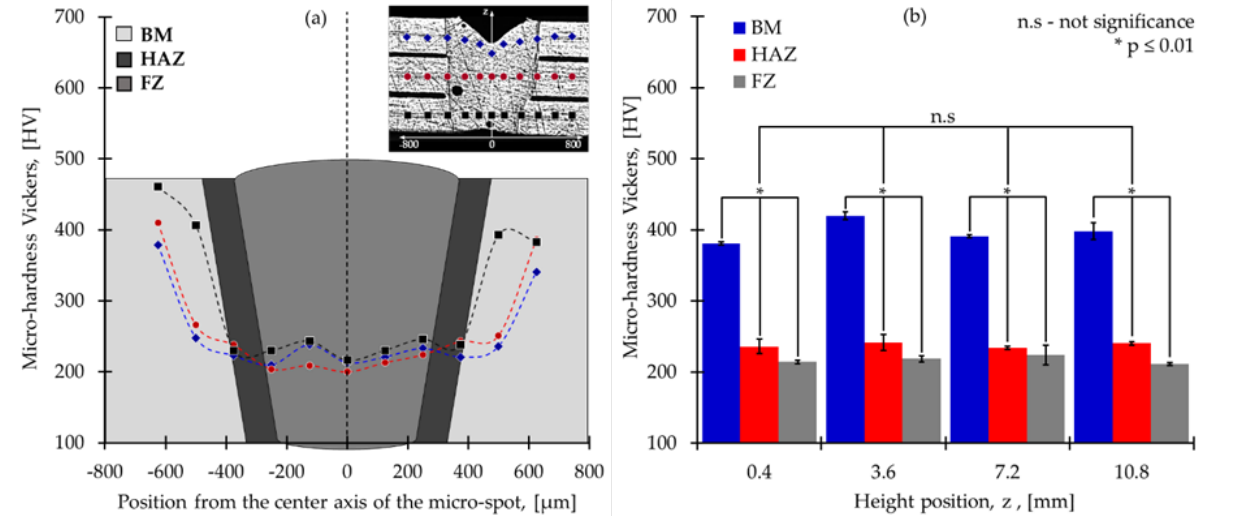
Figure 15. ( a ) Microhardness Vickers results in one spot and ( b ) microhardness results in one column of spots in all height scaffold.